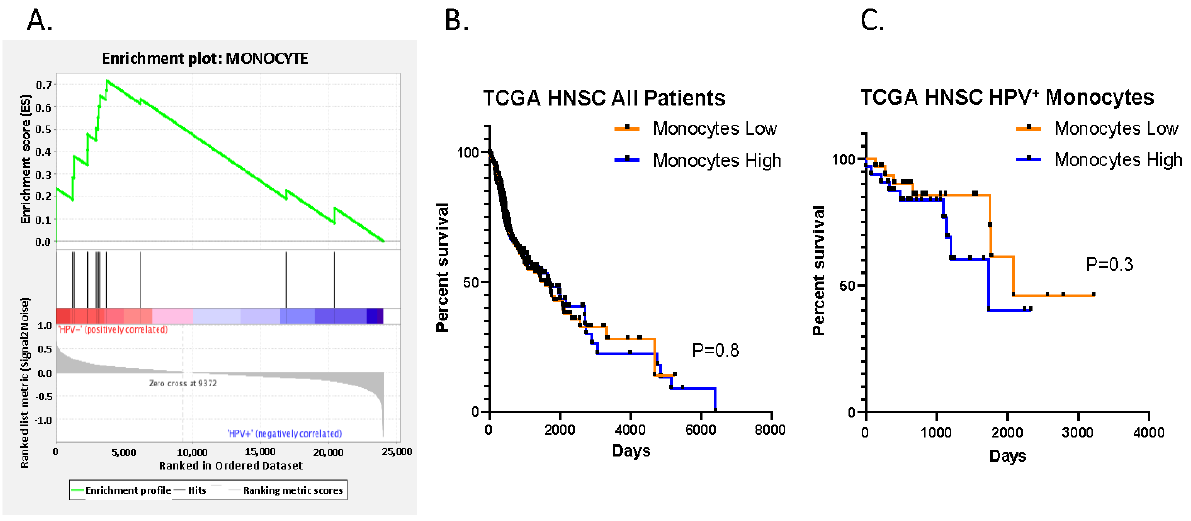
Figure 5. Increased expression of monocytic cell markers is present in HPV-negative vs. HPV-positive patients in the TCGA cohort. ( A ). GSEA analysis revealed a positive correlation of monocytic enrichment in the HPV- patients when compared to HPV+ patients in the TCGA cohort ( p = 0.0027, FDR q-value = 0.0059, FWER p -value = 0.014). ( B , C ). There was no correlation observed with the survival among all head-and-neck-cancer patients analyzed and monocyte status (high vs. low); p = 0.8 with all patients and within the HPV+ patient group ( p = 0.3). Granulocytes (specifically neutrophilic metamyelocytes), were also enriched in HPV+R+ compared to HPV+R- patients (Figure 6A). Additionally, in the TCGA dataset a similar pattern was found, in which this cell lineage was enriched in the more aggressive HPV- tumors when compared to HPV+ tumors (Figure 6B).